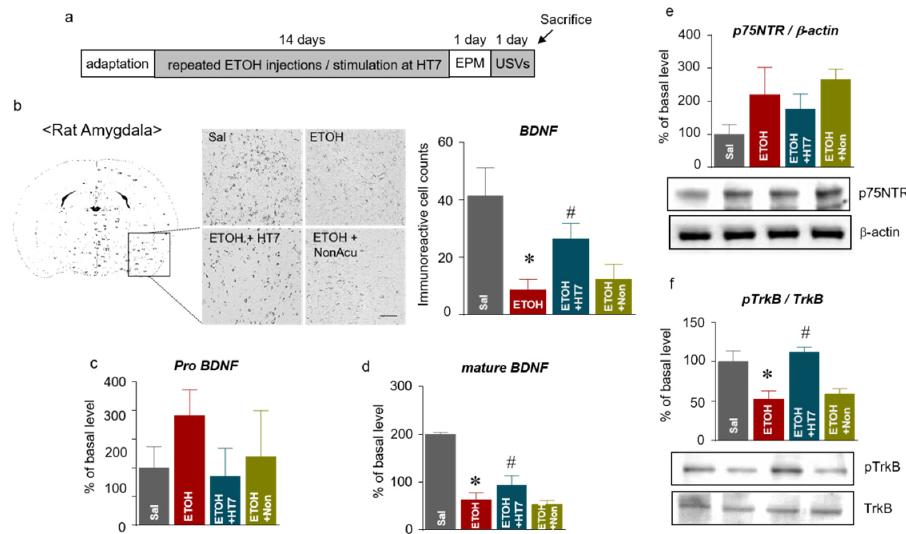
Figure 5. Schematic showing the acupuncture stimulation and sacrifice schedule ( a ). Representative micrographs showing the expression of brain-derived neurotrophic factor (BDNF) in the amygdala. The scale bar represents 100 μ m. The results are presented as the number of mature BDNF (mBDNF)-immunoreactive cells (n = 5–7 rats per group) ( b ). The levels of pro-BDNF in the amygdala (n = 46 rats per group) ( c ). The levels of mature BDNF in the amygdala (n = 4–6 rats per group) ( d ). The levels of p75NTR in the amygdala ( e ). The levels of pTrkB in the amygdala ( f ). The data were analyzed using repeated measures ANOVA followed by Tukey’s test. * p < 0.05 compared with the Sal group and # p < 0.05 compared with the ETOH group. Values are presented as means ±